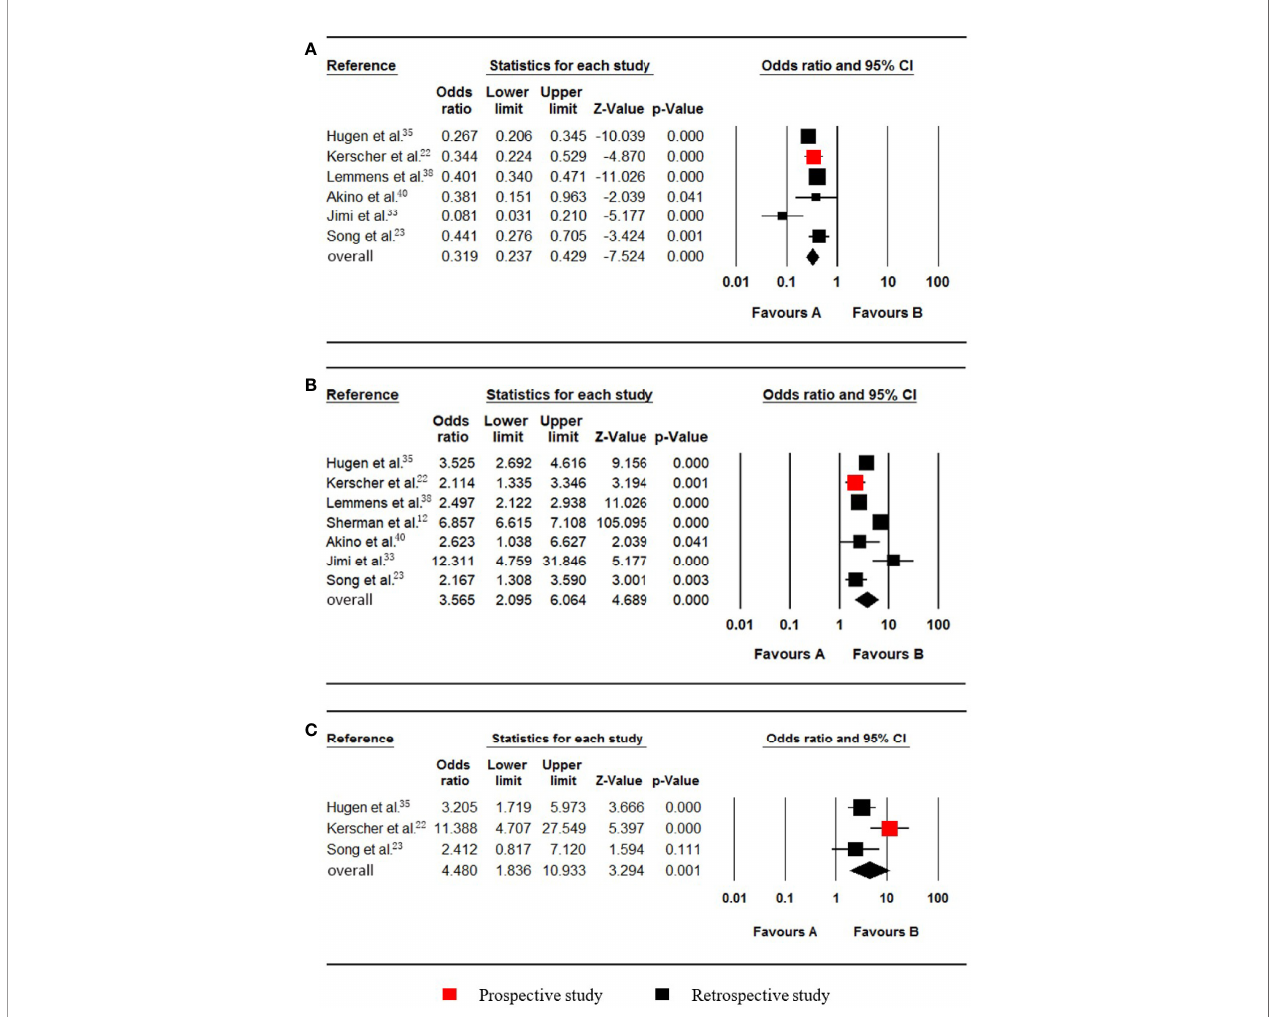
FIGURE 4 | Forest plot for nonmucinous adenocarcinoma (NMC), mucinous adenocarcinoma (MC) and signet-ring cell carcinoma (SRCC). Favours A, non-pmCRC. Favours B, synchronous pmCRC. (A) NMC. (B) MC. (C)